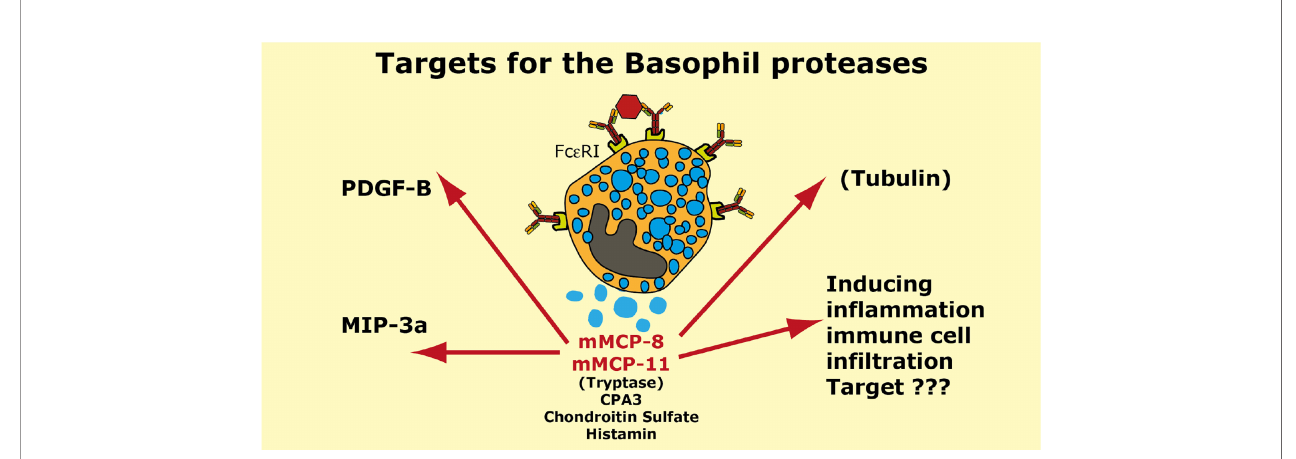
FIGURE 9 | Targets for the mouse basophil proteases mMCP-8 and mMCP-11. A number of potential targets for the mouse basophil proteases mMCP-8 and mMCP-11 is summarized. It is only for mMCP-8 that we so far have any targets identi fi ed in mouse PDGF-B, MIP-3a and tubulin. For both mMCP-8 and mMCP-11 we know that they induce in fl ammation and immune cell in fi ltration. Human basophils express the MC-tryptase and CPA3. Mouse basophils also express